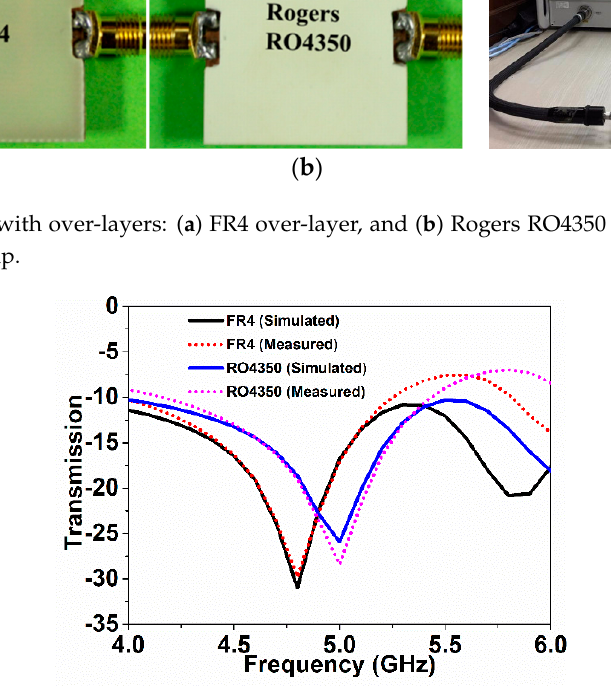
Figure 9. Transmission responses with FR4 and Rogers RO4350 over-layers.